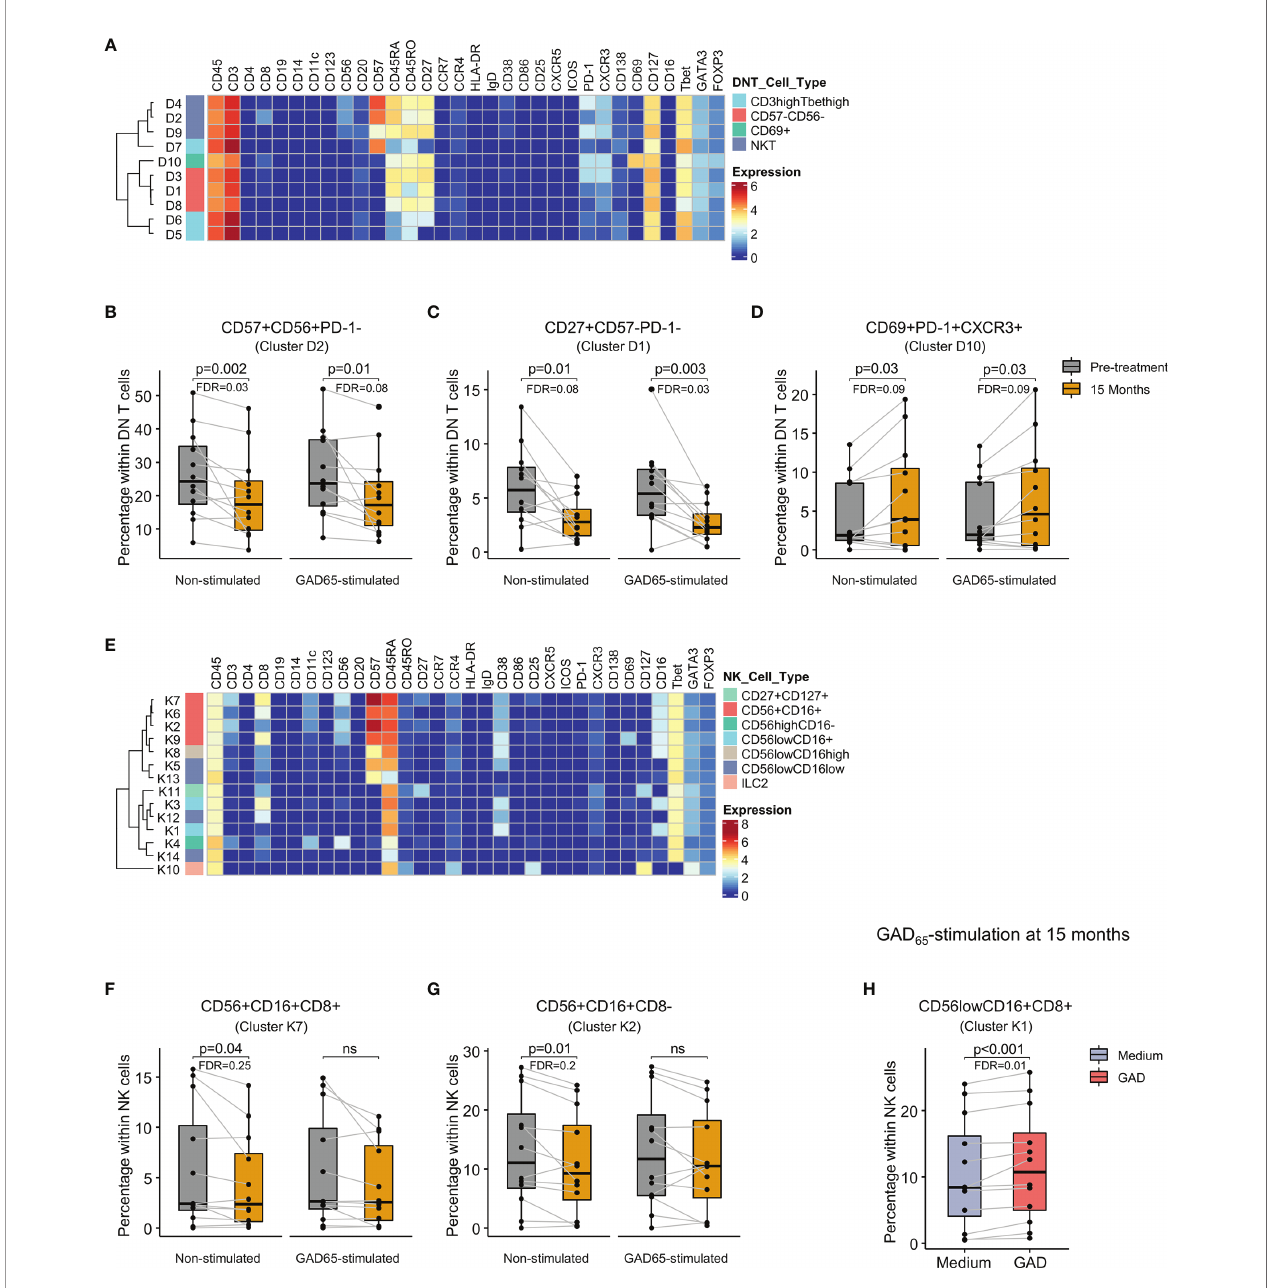
FIGURE 6 | Identi fi cation of cell clusters within double negative T and NK cells and changes after GAD-alum therapy. (A) Heatmap showing median marker expression across the 10 clusters identi fi ed within double negative T cells. Proportion of (B) CD57+CD56+PD-1- (cluster D2), (C) CD27+CD57-PD-1-(cluster D1), and (D) CD69 +PD-1+CXCR3+ (cluster D10) double negative T cells before (grey) and after treatment (yellow) in non-stimulated and GAD65-stimulated samples. (E) Heatmap showing marker expression across the 14 clusters identi fi ed within NK cells. Proportion of (F) CD56+CD16+CD8+ (cluster K7), (G) CD56+CD16+CD8- (cluster K2) NK cells before (grey) and after treatment (yellow) in non-stimulated and GAD 65 -stimulated samples. (H) Proportion after 15 months of treatment of CD56 low CD16+CD8+ NK cells in PBMCs cultured in medium alone (blue) or in the presence of 5 m g/ml of GAD 65 (red) for 72 hours. Dots represent individuals and boxplots indicate median and interquartile range. Wilcoxon signed-rank test. p < 0.05 was considered signi fi cant. FDR, False discovery rate (Benjamini – Hochberg); ns, non signi fi